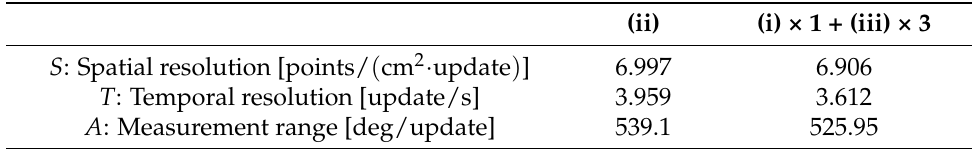
Table 2. Relationship between three control modes in terms of spatio-temporal resolution and measurement range derived from evaluation experiment results.